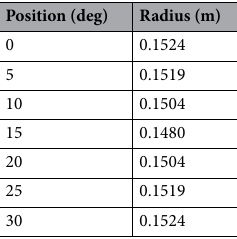
Table 3. Radius values for 5-deg steps of wheel rotation.